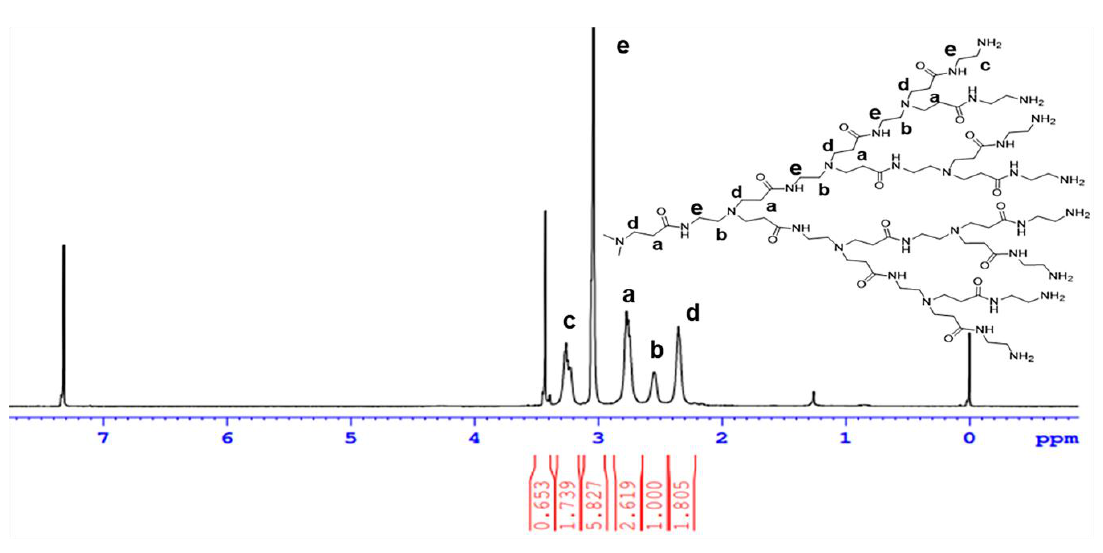
Figure 1. 1 H NMR spectrum of PAMAM G4.0.